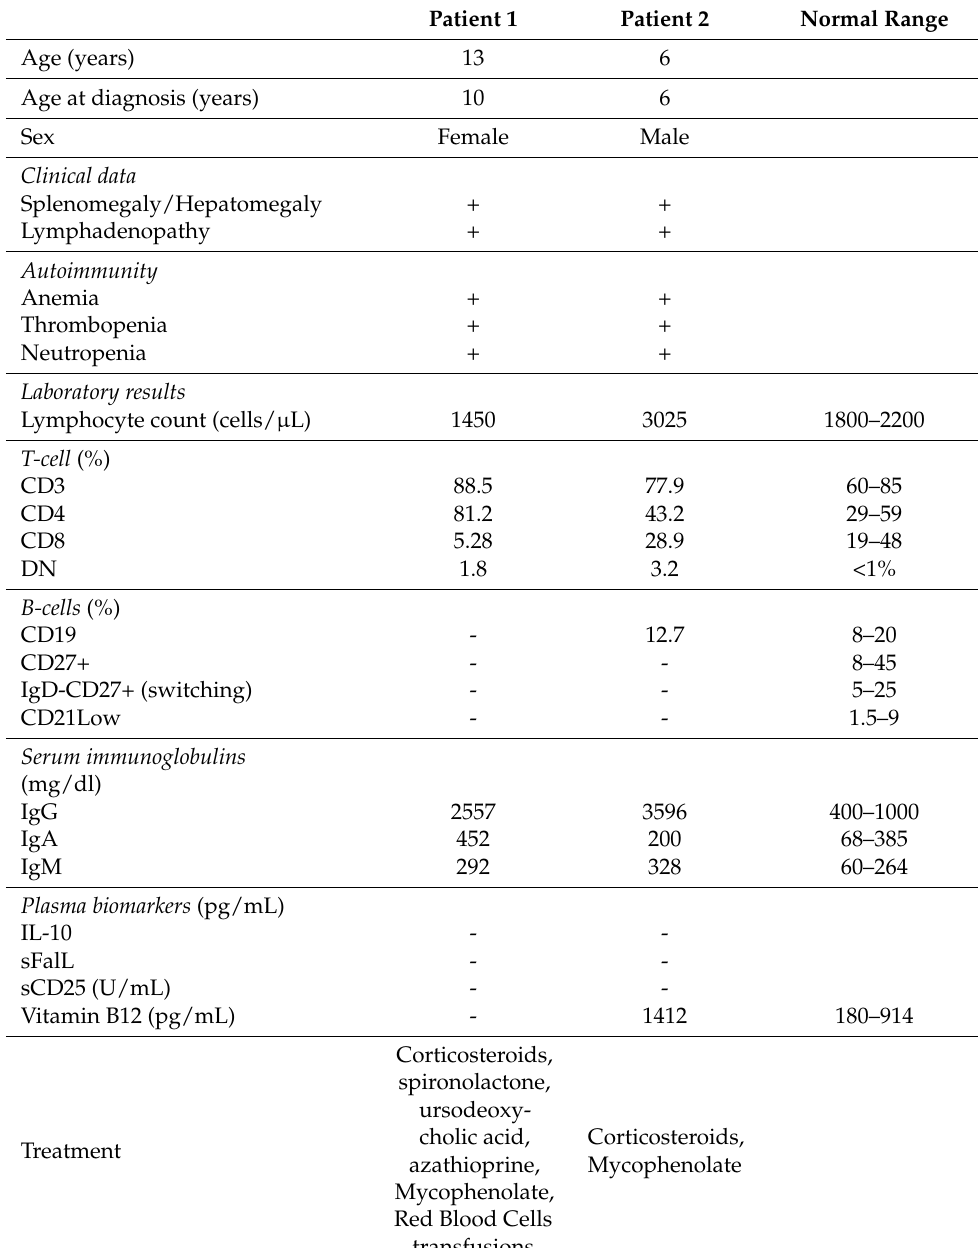
Table 1. Clinical and laboratory features of